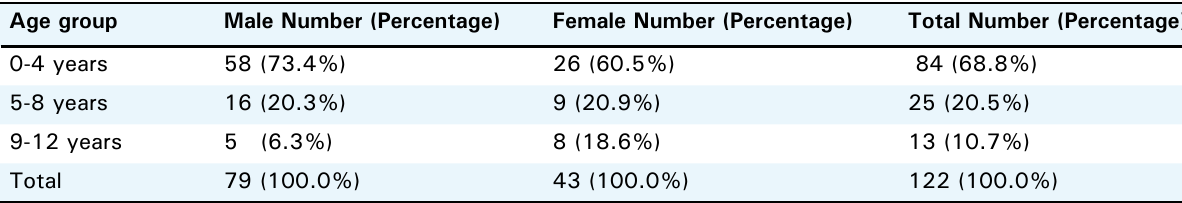
table 1. Age and distribution of foreign bodies in children